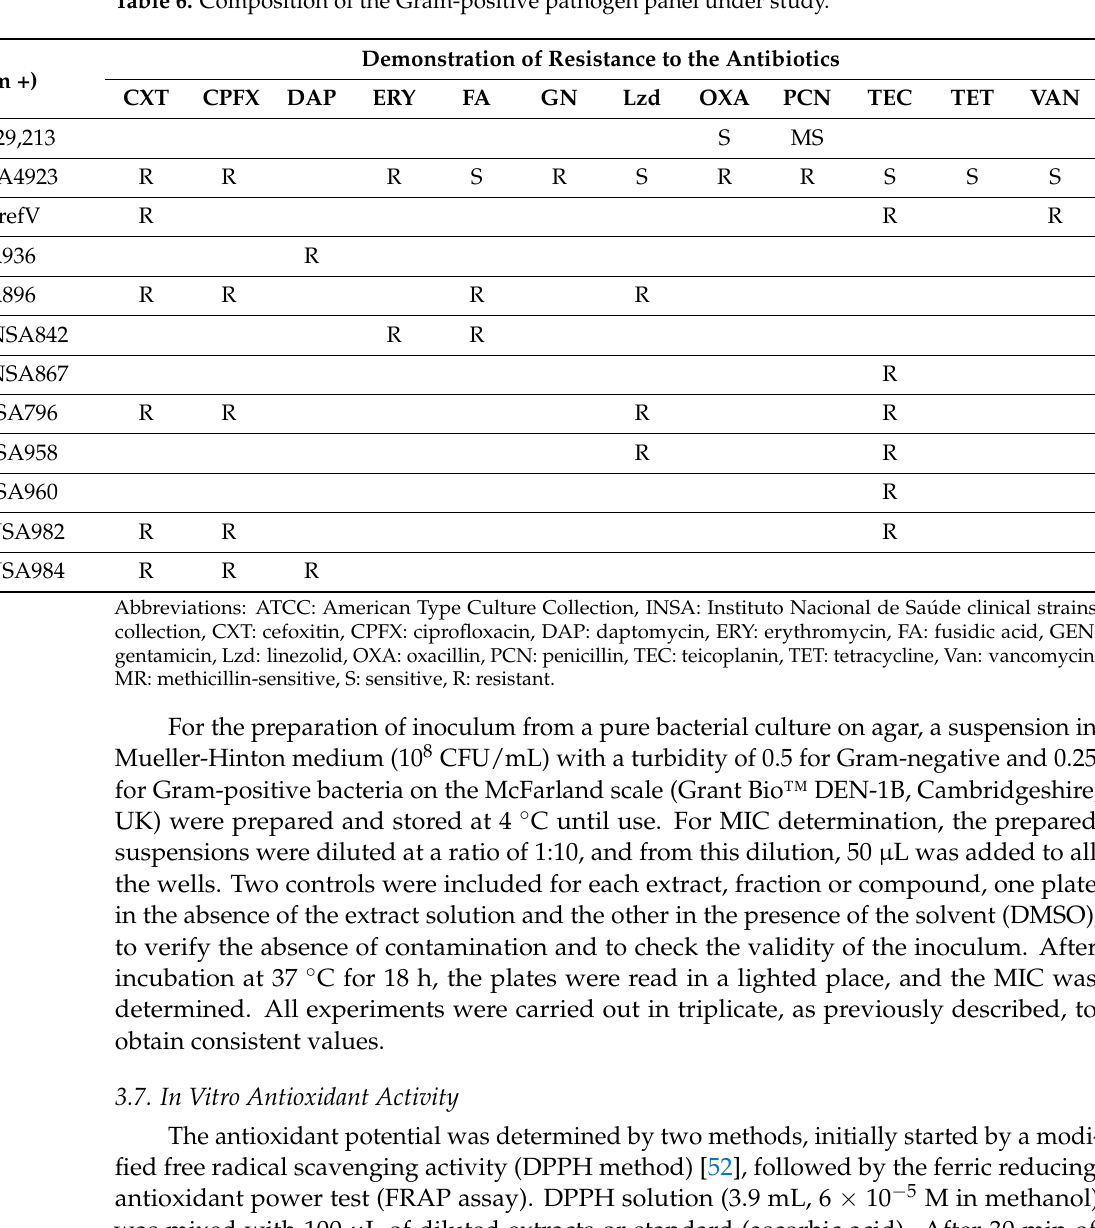
Table 6. Composition of the Gram-positive pathogen panel under